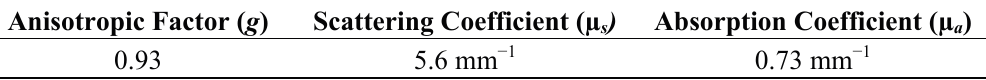
Table 1. Optical properties variables for live tissue [29].